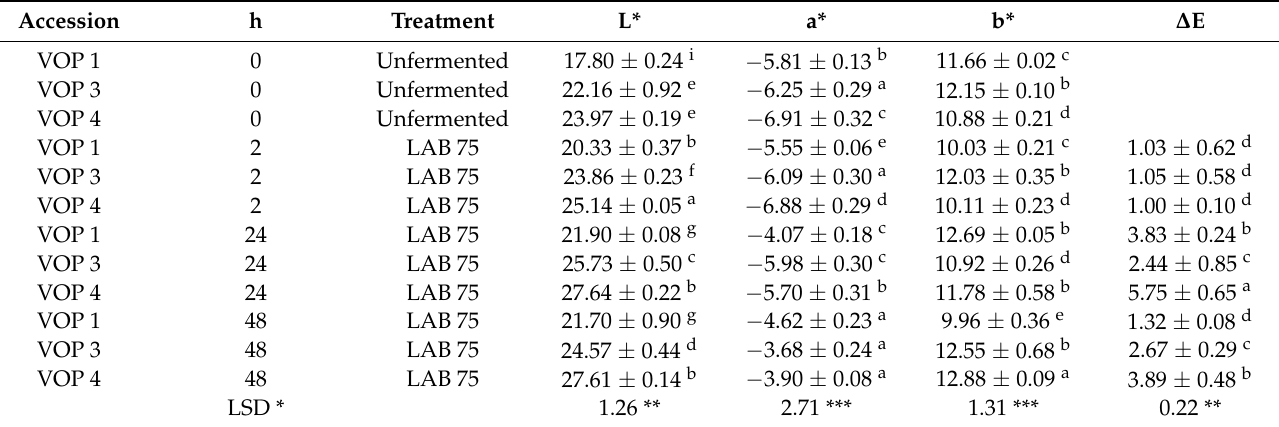
Table 3. Colour changes in fermented and unfermented cowpea leaf smoothies from three different cowpea